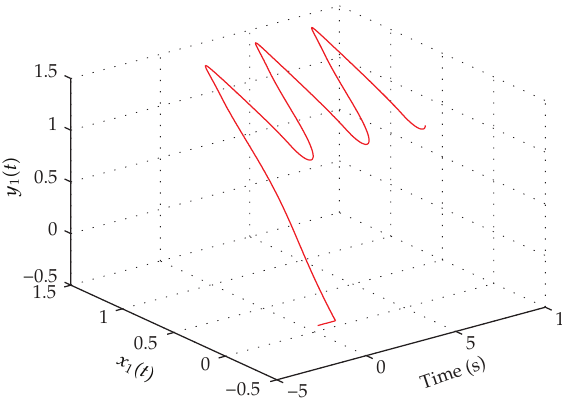
Figure 3: Phase response of state variable x 1 (cid:6) t (cid:7) and y 1 (cid:6) t (cid:7) .